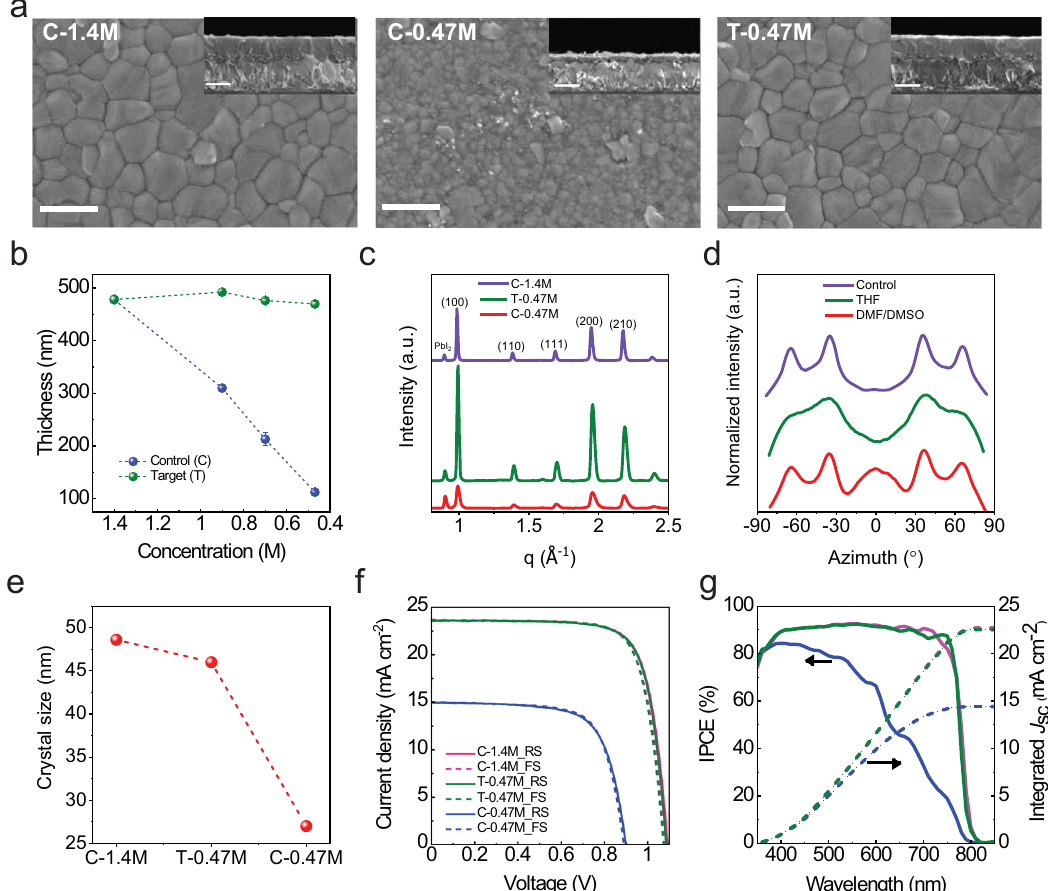
Fig. 2 Effects of perovskite precursor concentration on the fi lm properties. a SEM images of control and target triple-cation perovskite fi lms with different precursor concentrations. The insets show cross-sectional SEM images. The scale bar is 500 nm. b The relationship between perovskite precursor concentration and fi lm thickness. All fi lms were prepared using identical coating conditions. The fi lm thickness was measured by pro fi lometry. c GIWAXS scattering intensity vs. q . d Azimuthally integrated intensity of the ring in q range of 1A (cid:1) 1 assigned to (100) diffraction. e The change of crystal size of perovskite phase (2 θ ¼ 14 (cid:3) ) vs. precursor composition. J – V curves ( f ) and IPCE spectra ( g ) of triple-cation PSCs are based on different precursor